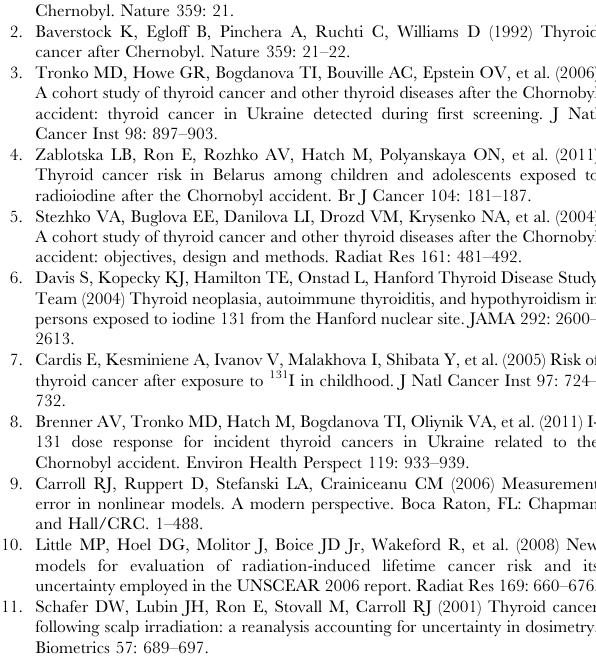
Table S1 Fits of multiple log-normal models as given by expression (S12) to measured dose data (1 st regression calibration model). Table S2 Fits of multiple log-normal models to mea- sured activity data (2 nd regression calibration model). Table S3 Effect of additional background variables on thyroid cancer prevalence risk (EOR/Gy). All use a linear EOR model, with regression calibration dose adjustments adapted from Kukush et al [13]. All CI are profile-likelihood